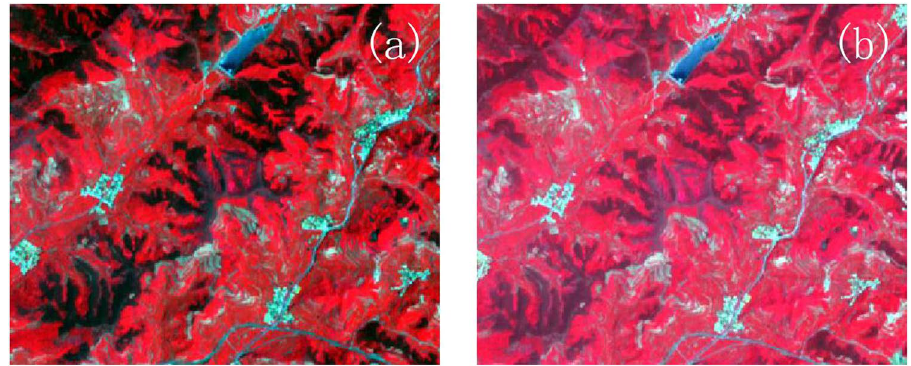
Figure 4. Image ( a ) is the local image before Minnaert correction, and image ( b ) is the local image corrected by Minnaert model.